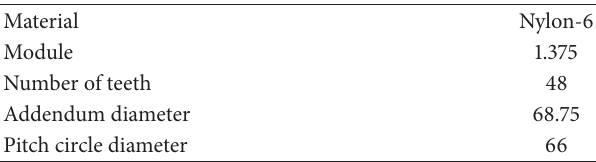
Table 9: Internal gear specification.